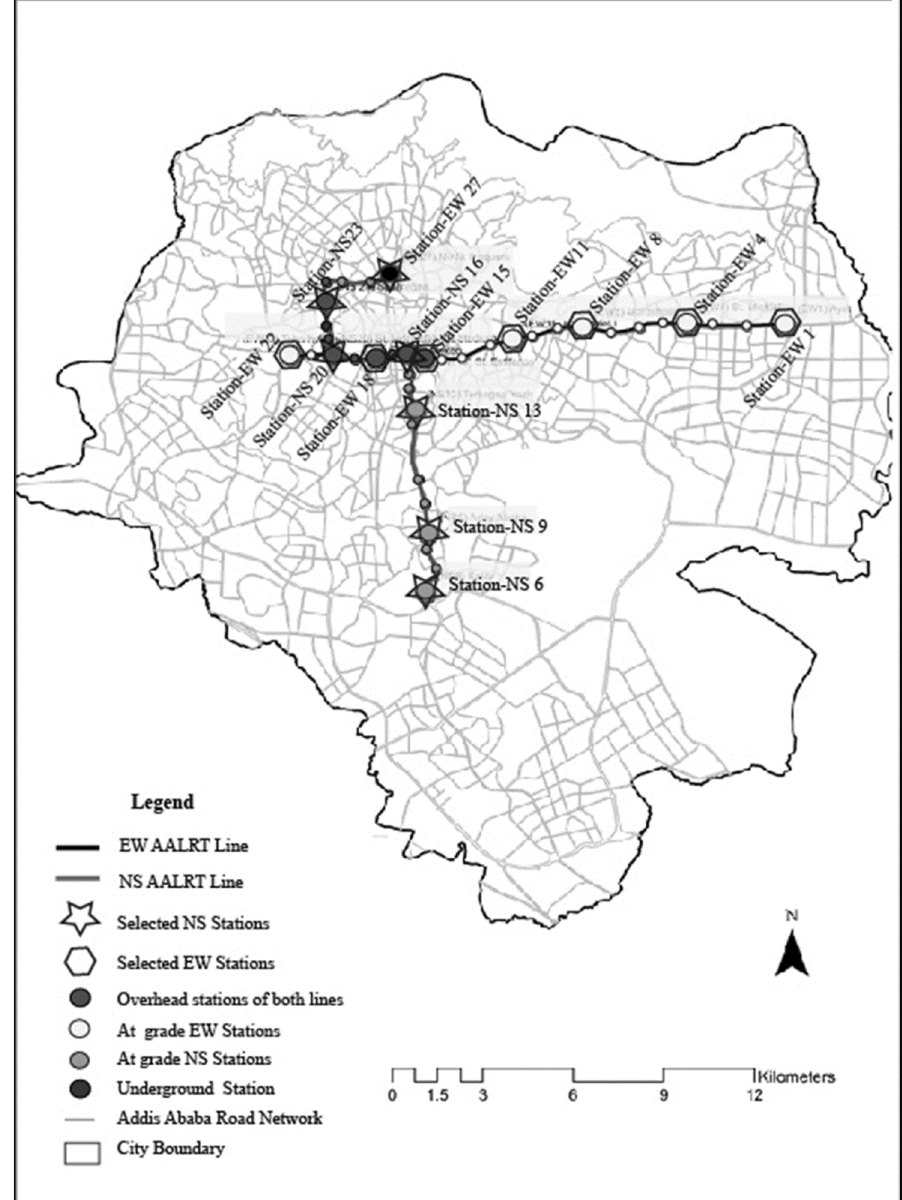
Fig. 1 Map of Addis Ababa LRT system and 14 selected stations from both lines ( Source : Reorganized and edited by authors based on data